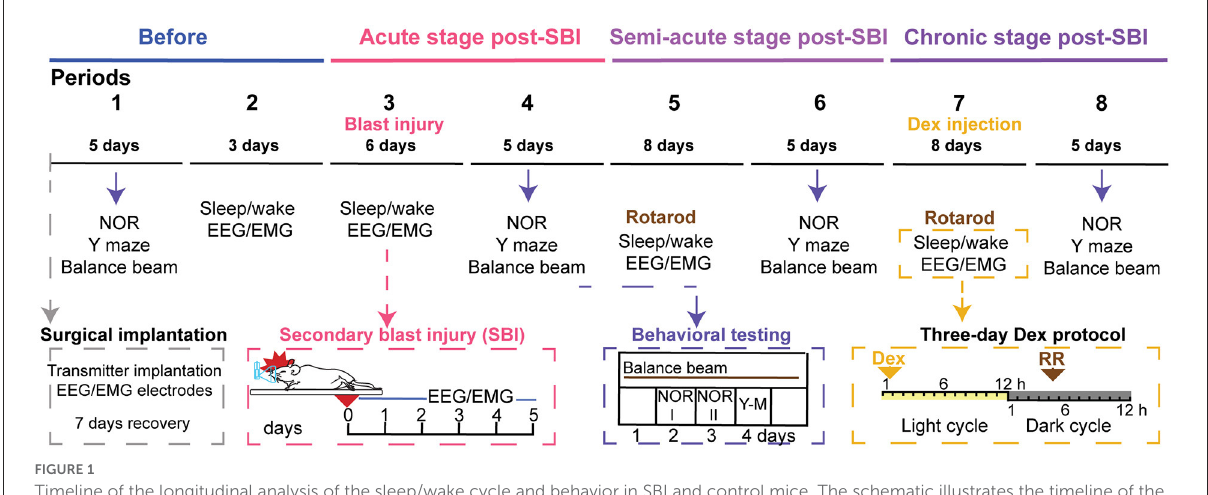
FIGURE1 Timeline of the longitudinal analysis of the sleep/wake cycle and behavior in SBI and control mice. The schematic illustrates the timeline of the repeated tests applied to blast injured and control mice before and several weeks after blast injury. The top line shows the time scale divided into periods. Seven days before period one, animals were implanted with a wireless transmitter (gray box). Then in period 1 (5 days), mice were exposed to a battery of motor and cognitive tests, including novel object recognition (NOR), Y maze(Y-M), and balance beam. After this evaluation, the sleep/wake cycle was monitored for 24h on three consecutive days (period 2). Next, on day 0 of period 3, mice were subjected to a blast and sham procedure, respectively, while animals were anesthetized. We monitored EEG and EMG activity immediately after SBI and for six consecutive days. Later in period 4, we repeated motor and cognitive testing (blue box). After that, we studied EEG/EMG activity in period 5 for 8 days, and mice executed the rotarod (RR). We repeated the cognitive and motor tasks for the third time and for 5 days (period 6). Subsequently, while we were monitoring EEG/EMG activity (period 7), we injected Dex (0.15 mg/kg) within the first hour of the light cycle, and 16h later, mice ran on the rotarod (orange box). Lastly, we evaluated cognitive and motor behavior a week after Dex injection (period